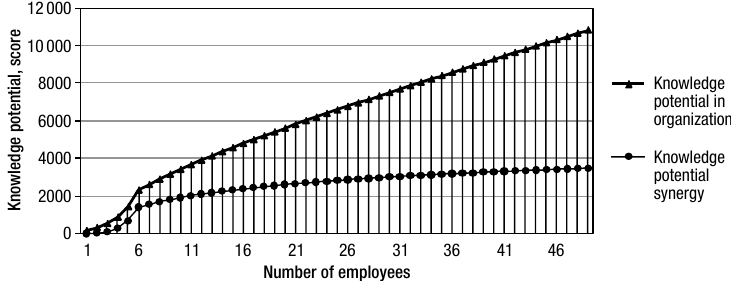
= 150 score; µ = 1; η = 1; r = 5) di z n